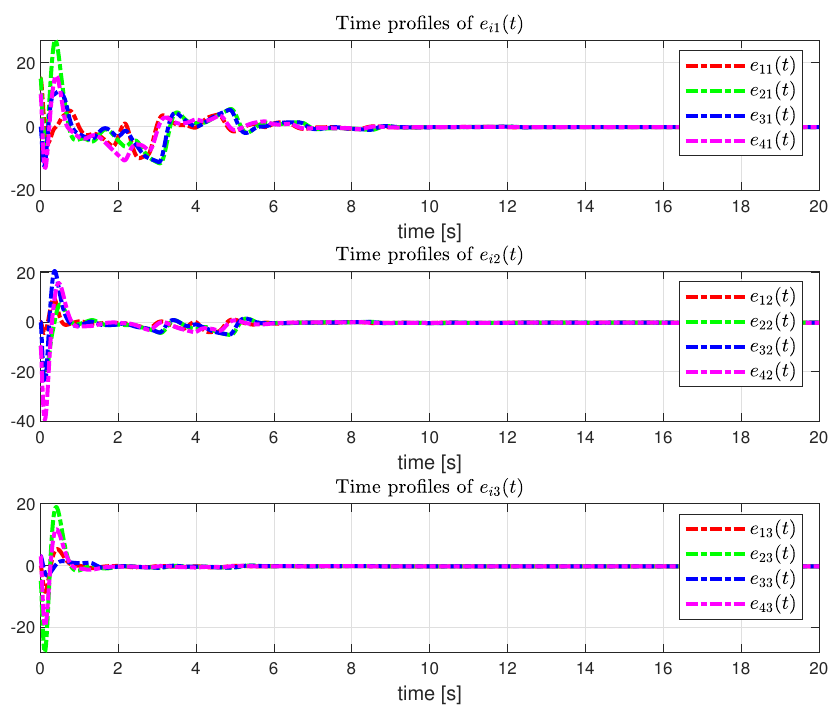
Figure 13. Performance of the control method proposed in this paper under communication network ¯ with T c = 0.3 G σ ( t )